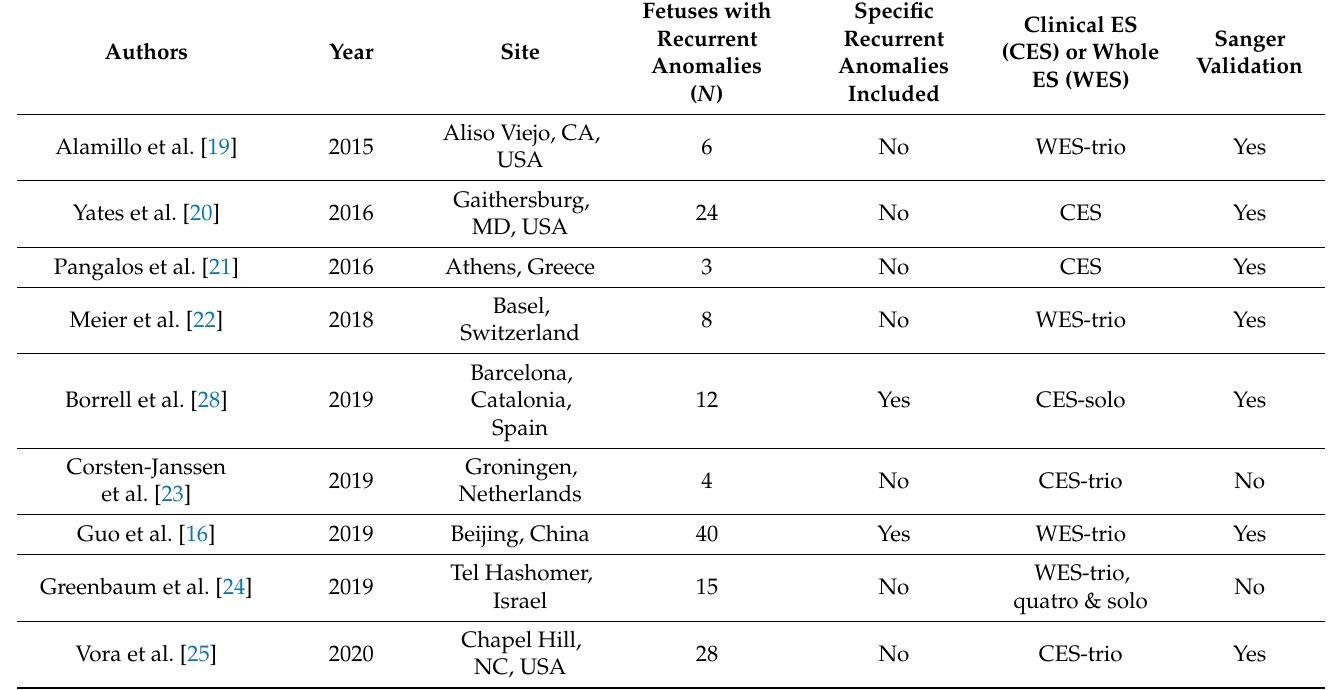
Table 1. Features of the nine studies included in this systematic review and